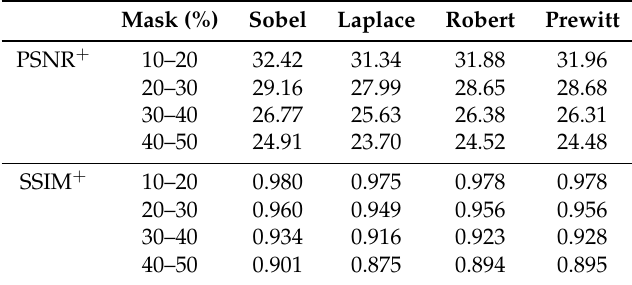
Table 1. Comparison results of networks with different operators in loss function in terms of different ratios of mask on